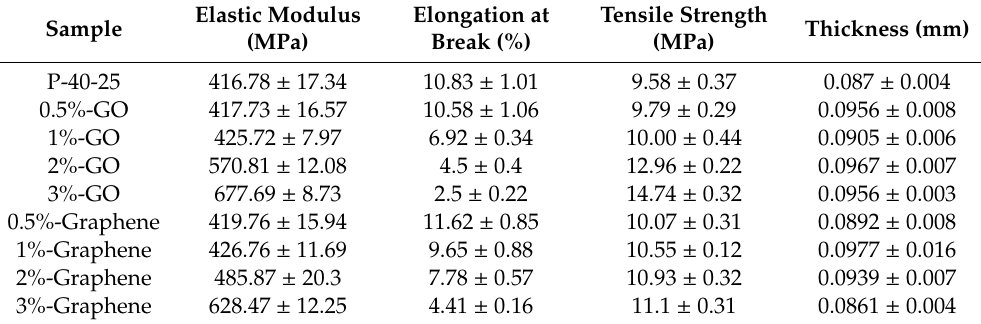
Table 3. Tensile properties of the blend